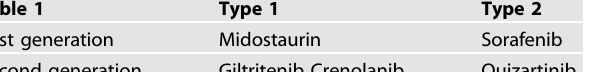
Table 1. FLT3 inhibitors are characterized based on mechanism of inhibition and generation. Table